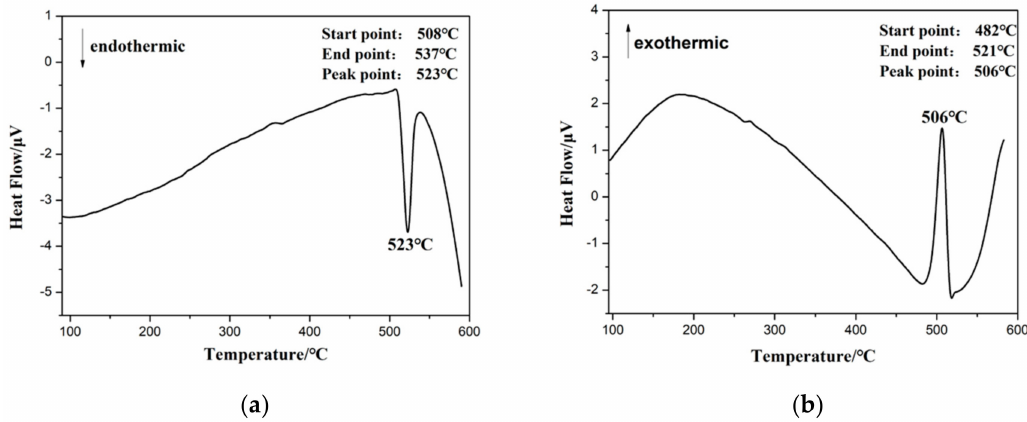
Figure 1. Endothermic (DSC) curve ( a ) and exothermic (DSC) curve ( b ) of the as-cast alloy.